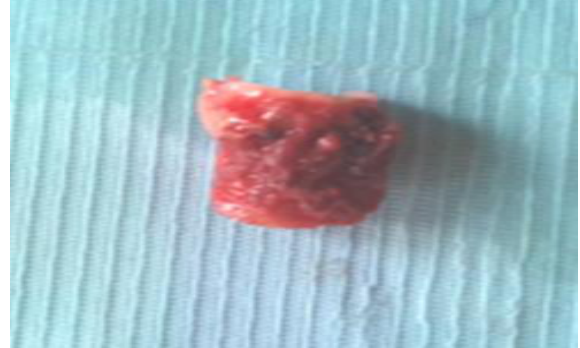
Figure, 6 : Shows binding polypropylene mesh and bone marrow with trachea of dog in G2 at 60 postoperative day.